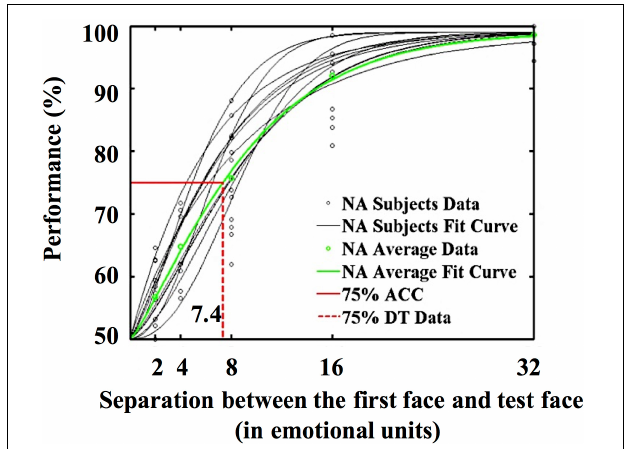
FIGURE 1 | Function fitting results of the 75% discrimination threshold of the face